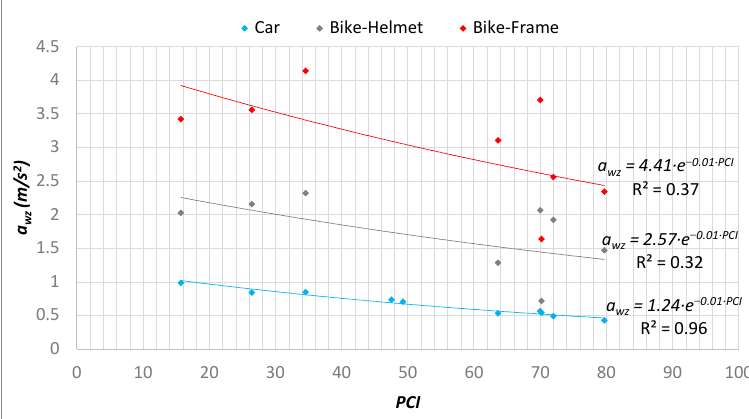
Figure 18. a wz -PCI regression considering different vehicles and sensors positions.